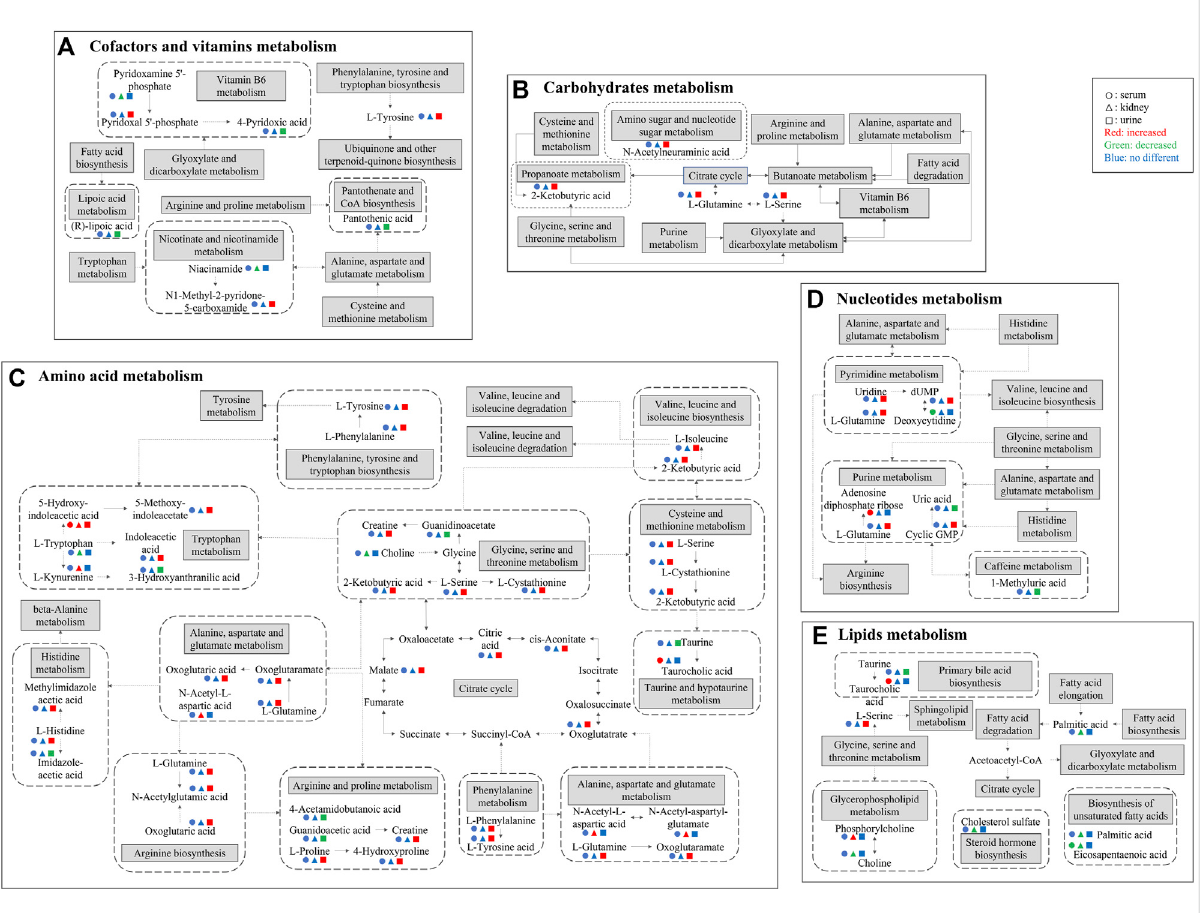
FIGURE 8 Major differential metabolites and metabolic pathways interrupted by CDDP and regulated by HK. (A) Cofactors and vitamins metabolism; (B) Carbohydrates metabolism; (C) Amino acid metabolism; (D) Nucleotides metabolism; (E) Lipids metabolism. Solid arrows indicate direct effects and dotted arrows indicate indirect effects. The attenuated markers in serum, kidney, and urine are represented by circle, triangle, and rectangle respectively.ComparedtoCDDP+HKandControlgroups,increased,decreased,and “ nodifferent ” levelsarepresentedinred,green,andblue, respectively.